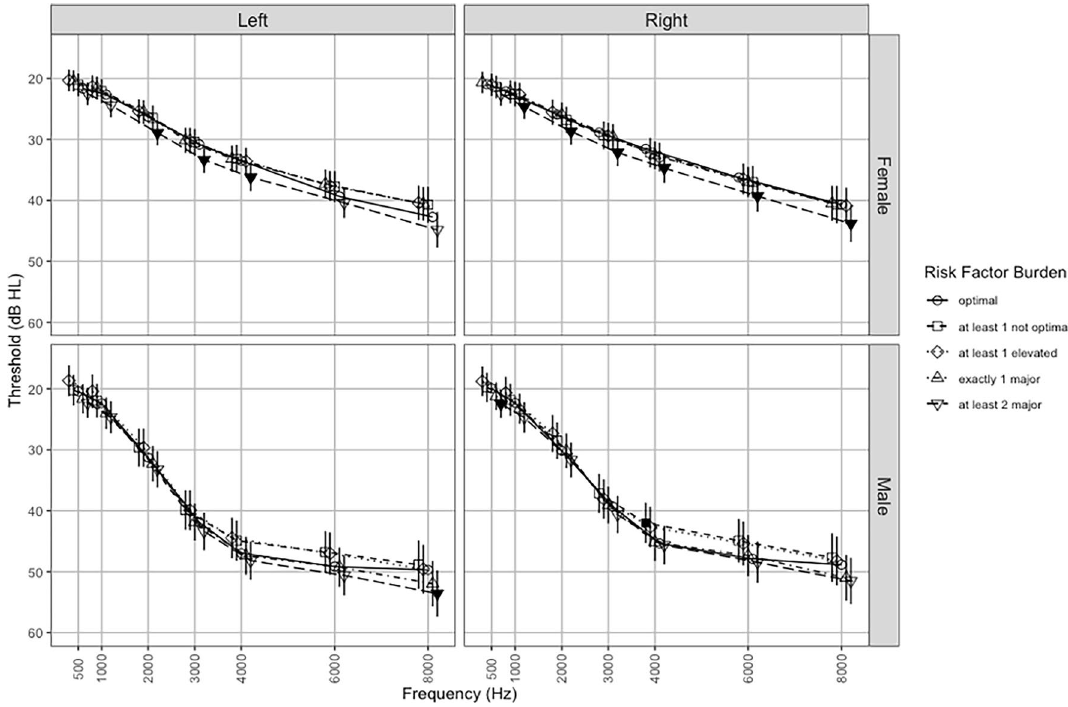
Figure 2. Sex-stratified audiograms * (mean [95% CI] by ear and CVD risk group. Filled symbols indicate P < 0.05 in comparison to optimal CVD (reference group). Data points jittered on x-axis to provide greater visual clarity of error bars. *adjusted for age, hearing aid use, BMI, noise